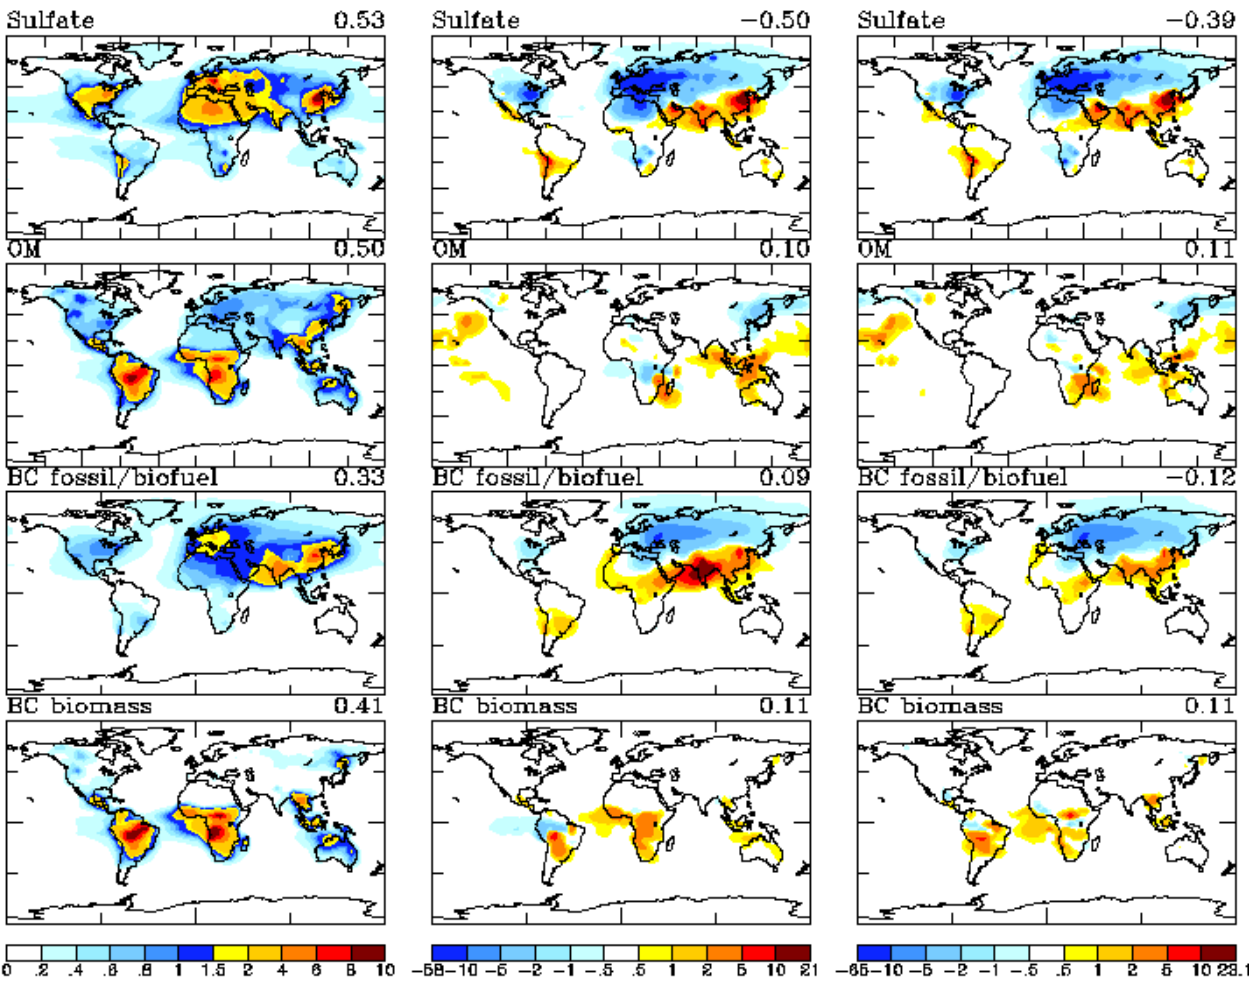
Fig. 1. Average annual surface layer mass concentrations (µgm − 3 ) for sulfate and organic matter (OM) from all sources and black carbon (BC) from fossil/bio-fuel and biomass sources for the Beig emissions for 2000 (left panel). Differences between simulations from 1990 to 2000 are shown for the Beig (middle panel) and Bond (right panel) emissions. Values for BC are multiplied by a factor of 10 to facilitate comparison with other aerosols. Global values are listed on the rhs.